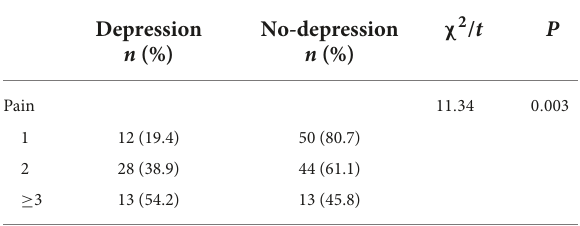
TABLE 2 Clinical related factors between depression and no-depression in MM